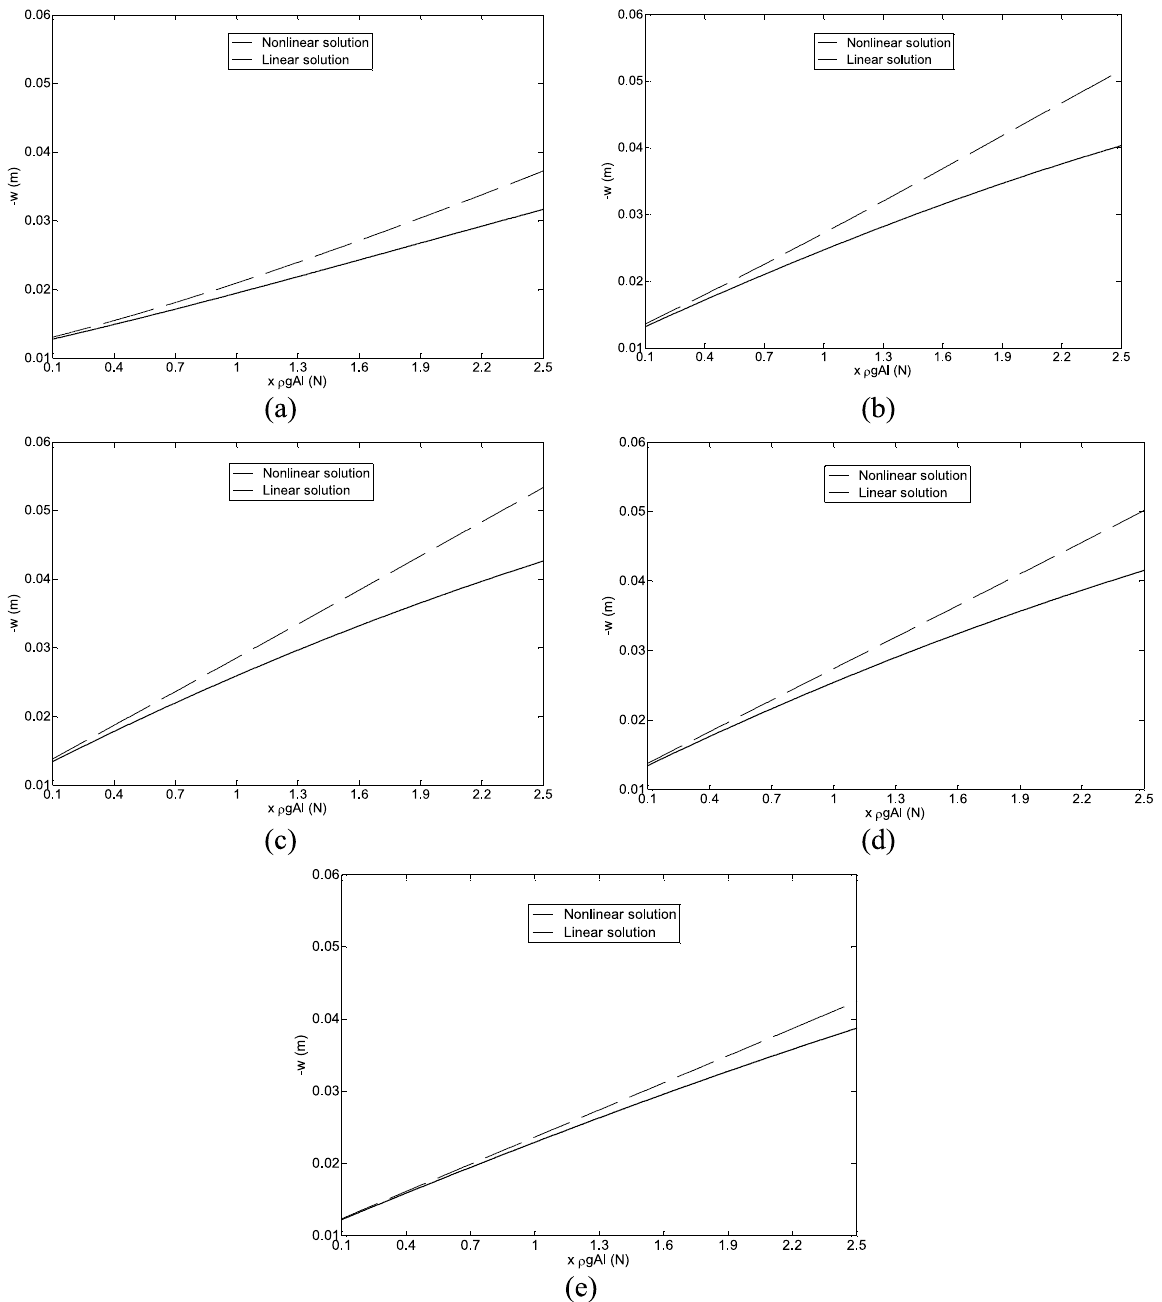
Fig. 6. Variation of the maximum dynamic response of a point at the middle of a self-weight Timoshenko beam with θ = 36 ◦ vs. different values of equivalent concentrated moving forces for different velocity ratios; (a) α = 0.25, (b) α = 0.5, (c) α = 0.75, (d) α = 1, (e) α = 1.25. (—–) nonlinear solution, ( ) linear solution. The maximum dynamic displacement variation ( w ) of mid-point of an inclined self-weight Timoshenko beam with inclination angle of θ = 36. ◦ vs. equivalent moving concentrated forces using both linear and nonlinear approaches for different velocity ratios of α = 0.25, 0.5, 0.75, 1 and 1.25, are depicted in Fig. 6-a to 6-e, respectively. It